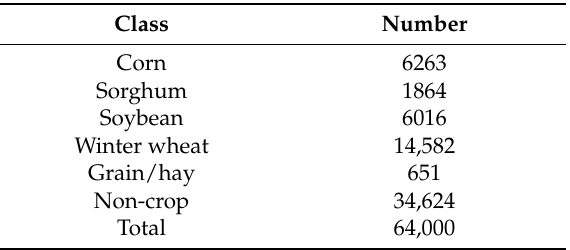
Table 2. Number of reference data.